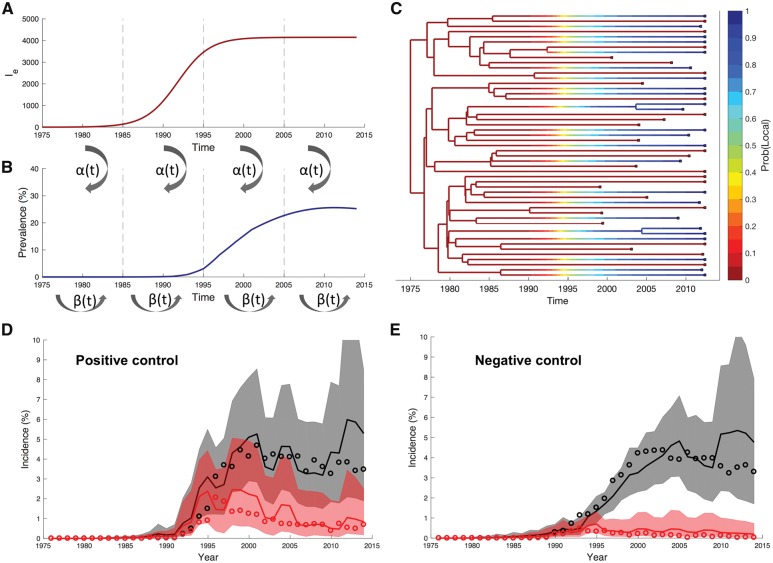
Schematic of the phylodynamic model and its validation on simulated data. Epidemic dynamics simulated under the model showing the number of infected individuals in the external population Ie (A) and the local population (B). Transmission events from the external to the local population occur at rate α(t) and within the local population at a rate proportional to β(t). Both of these rates are time dependent and vary in a piecewise constant manner to accommodate changes in behavior, treatment or other interventions. Although not shown here, viral lineages can also be exported from the local population through transmission to the external population. (C) A simulated phylogeny generated under the same phylodynamic model. Each lineage is colored according to its probability of being in the local population (blue). These probabilities were computed under the model based on each lineage’s sampling location and the estimated transmission rates between populations. (D and E) Total incidence (gray) and incidence attributable to external introductions (red) inferred from simulated phylogenies. Solid lines represent the posterior median estimate, shaded regions mark the 95 per cent credible intervals and open circles mark the true yearly incidence known from the simulations. In the positive control (D), we correctly infer that external introductions played a large role in driving and sustaining the local epidemic; whereas in the negative control (E), we correctly infer that external introductions only played a minor role in seeding the epidemic.